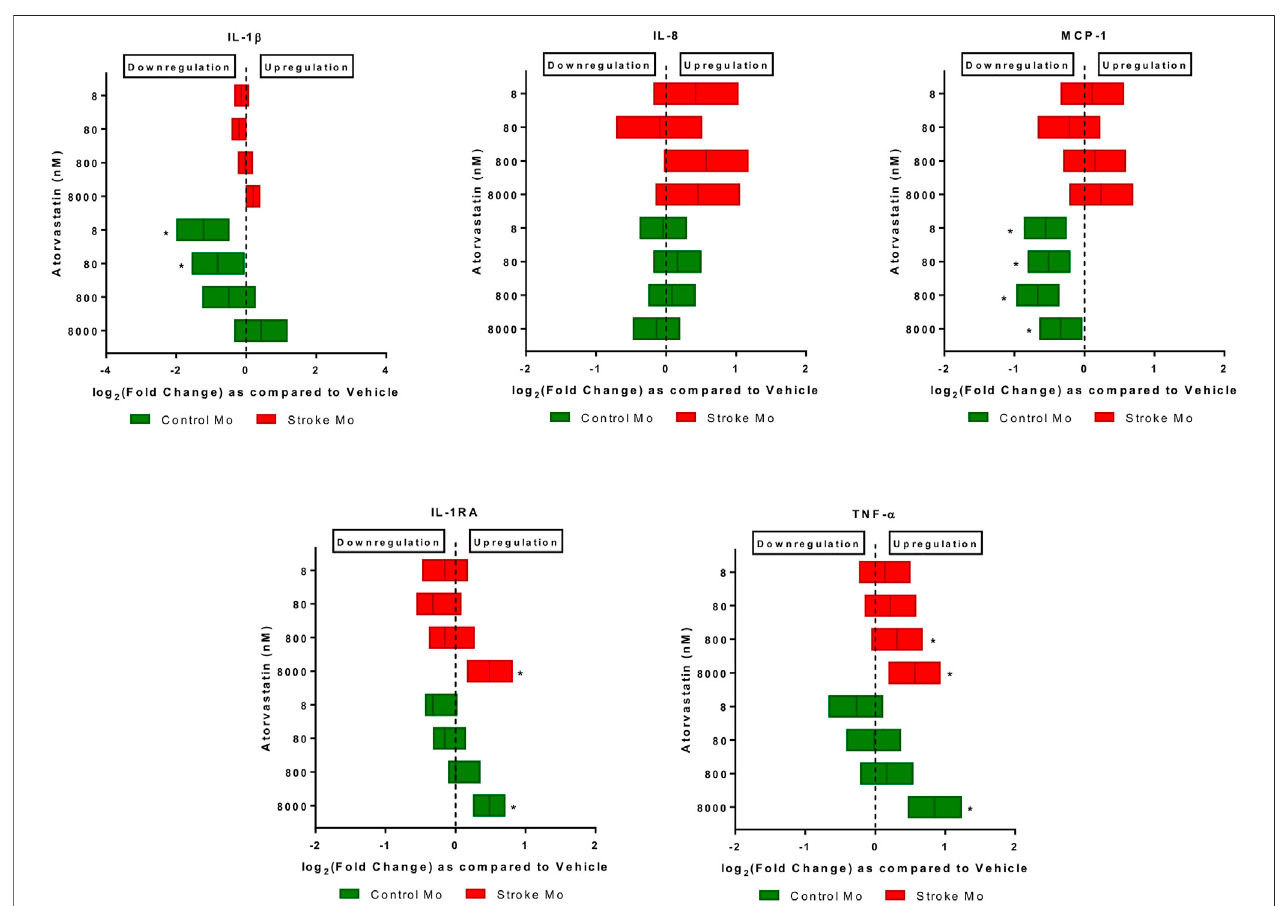
FIGURE 1 | Atorvastatin alters the secretome of monocytes from healthy controls and stroke patients after 24 h of exposure. Atorvastatin increased IL-1RA and TNF- α secretion from stroke patient derived monocytes as well as healthy control monocytes at 8 µM dose. Atorvastatin had no effect on secretions of IL-8, IL-1 β and MCP-1 from stroke monocytes, but decreased the MCP-1 secretion from healthy control monocytes. Signi fi cance is shown by * p < 0.05.